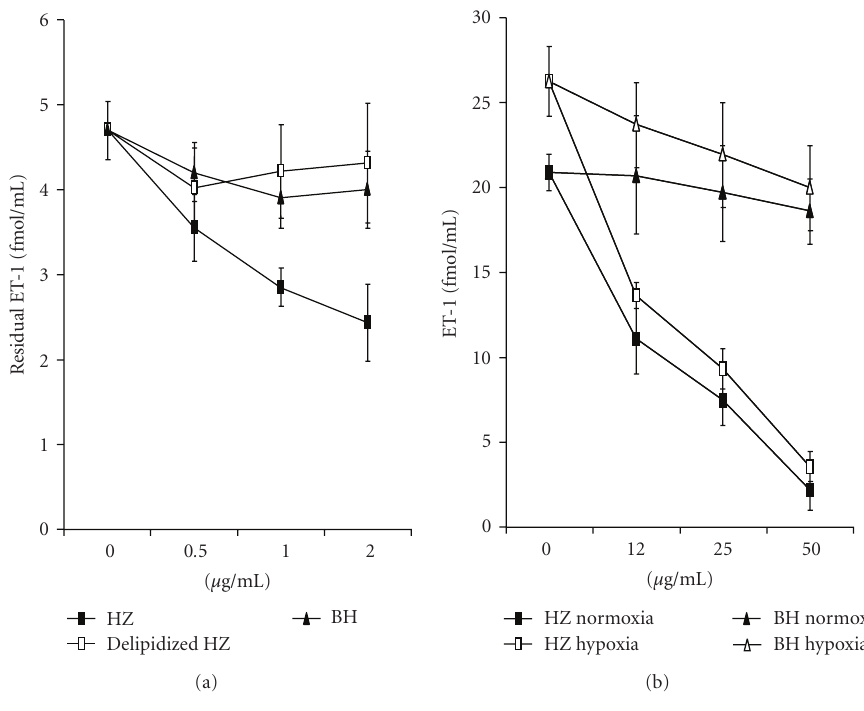
Figure 5: E ff ect of incubation of haemozoin with ET-1 synthetic or produced by HMEC-1. (a) ET-1 (5fmol/mL) was incubated for 24 hours in the presence of di ff erent concentrations of native HZ (black square), delipidized HZ (empty square), or BH (triangle). After incubation the recovery of ET-1 was determined by ELISA. Results represent mean ± SD from three di ff erent experiments. (b) HMECs-1 were treated for 24 hours in the presence of di ff erent concentration of native HZ (square), BH (triangle) under normoxic (black symbols), or hypoxic conditions (empty symbols). Supernatants were assayed for the presence of ET-1 by ELISA. Results represent mean ± SD from three di ff erent